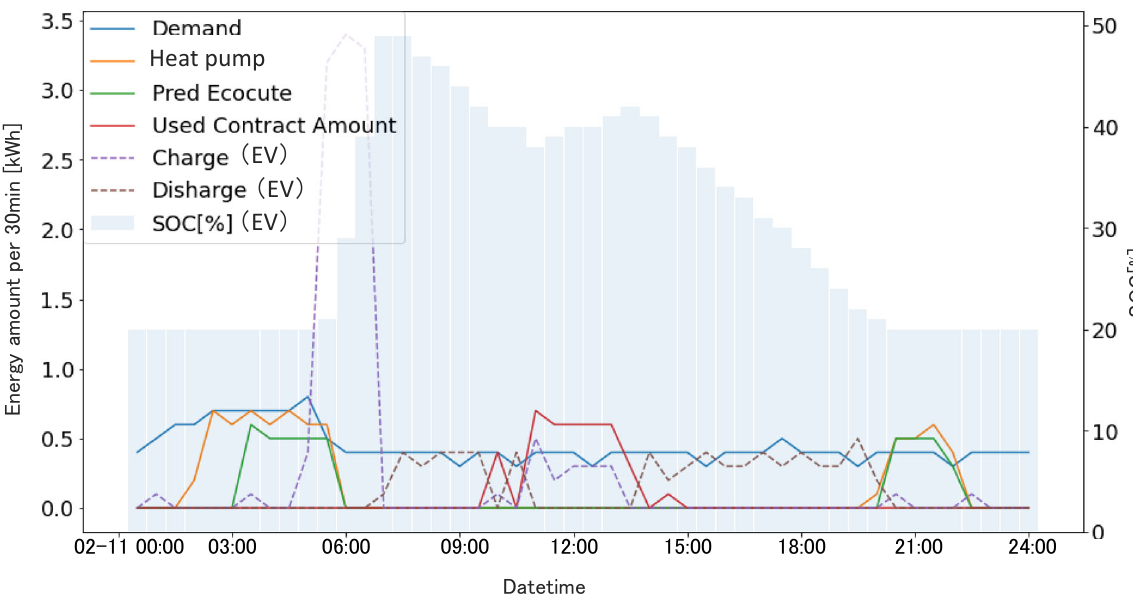
Figure 8. Electricity usage of HOME1 on one day during Phase 3 of the experiment.